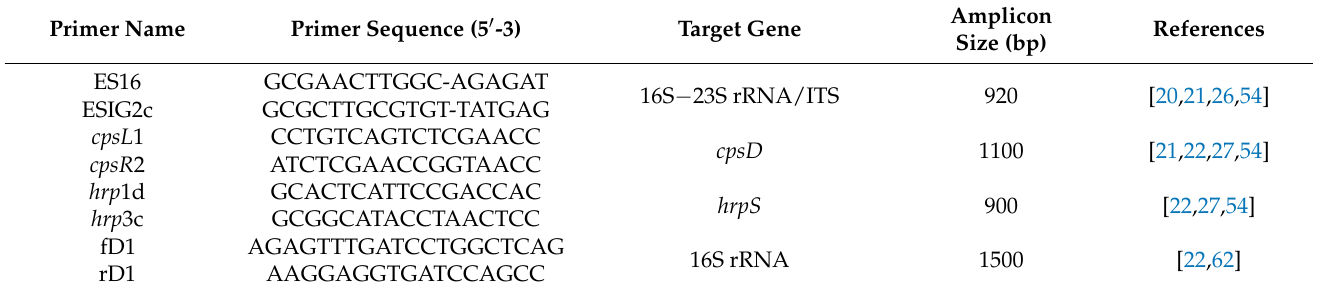
Table 2. Primers and their sequences, targeted gene regions, and amplicon sizes used in single-plex PCR to identify the jackfruit-bronzing bacterium P. stewartii subsp. stewartii